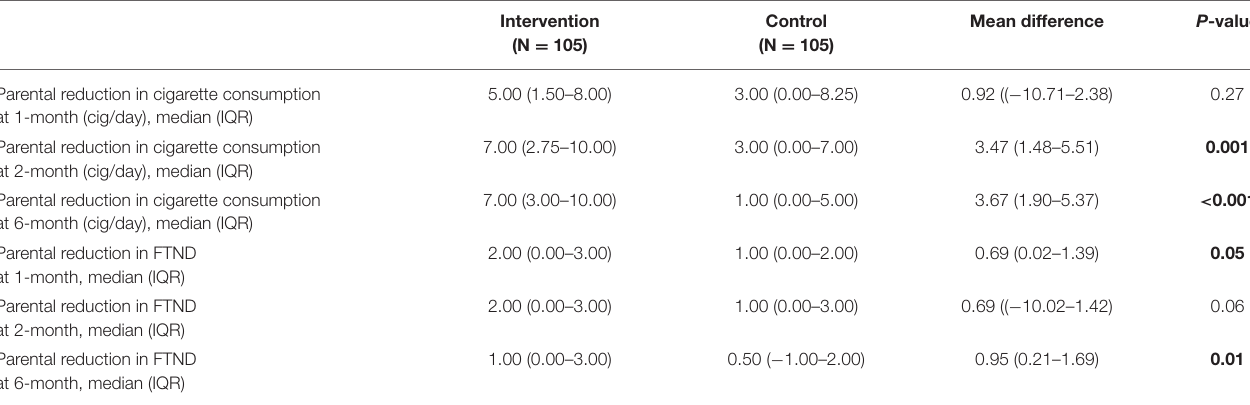
Intervention Control Mean difference P -value (N = 105) (N = 105)